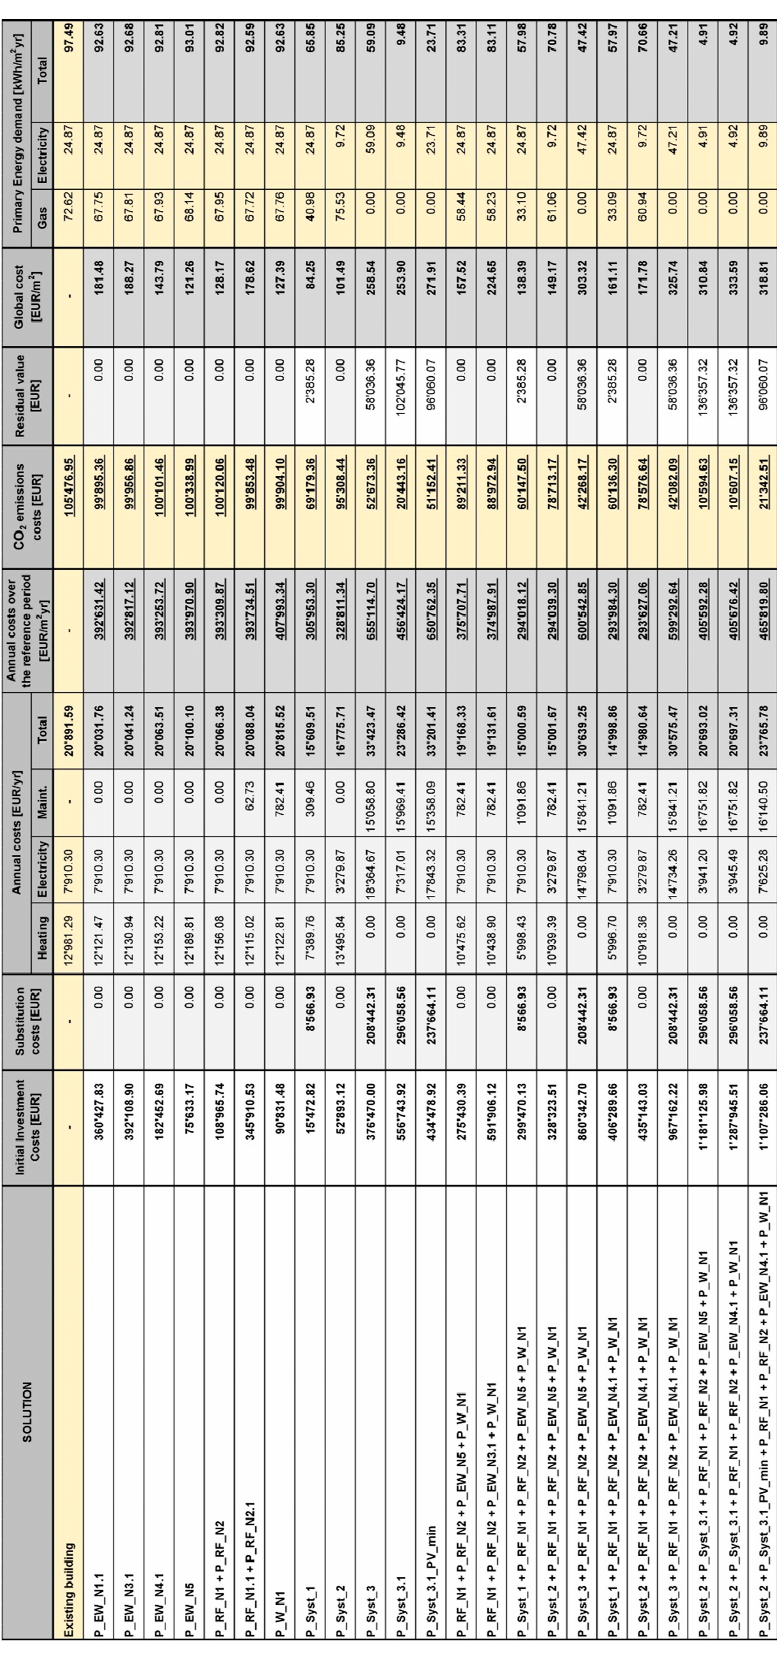
Figure A3. Summary table of cost-optimal methodology for macroeconomic scenario with discount rate equal to 3% for Poliziano school.